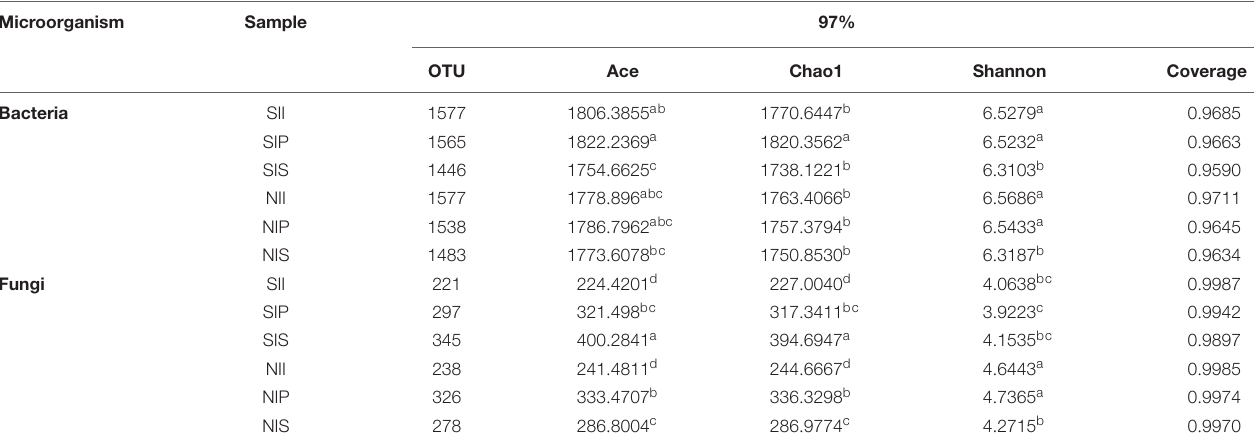
TABLE 1 | Diversity and richness of the peanut rhizosphere (IP), sorghum rhizosphere (IS), and interspecific interaction zone (II) soil microbial communities at the phylum and genus levels under different soil conditions (S, 0.25% salt-treated soil condition; N, normal soil condition). Microorganism